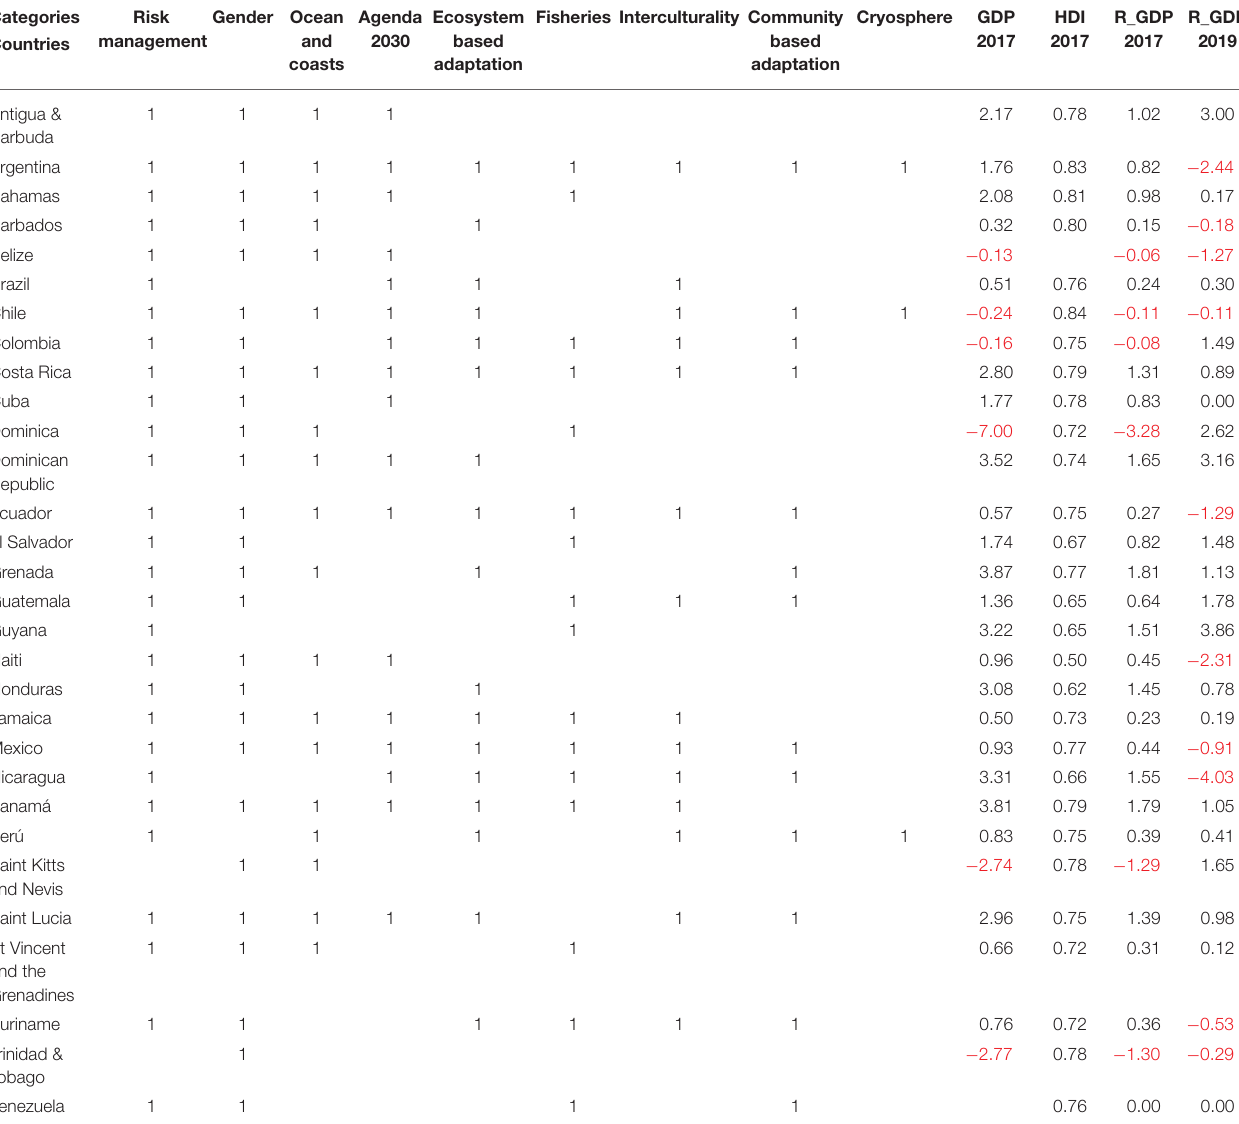
TABLE 1 | Specific categories listed as targets to meet either UNFCCC’s climate targets or specific SDGs from 31 countries from Latin American and the Caribbean region (LAC) according to the NDC Registry*. Countries are alphabetically listed. Economic indicators, i.e ., Gross Domestic Product (GDP) per capita, Human Development Index (HDI), and specific GDPs for 2017 and 2019 relative to overall world GDP estimates for these specific years were world extracted from World Development Indicators**, at the World Bank